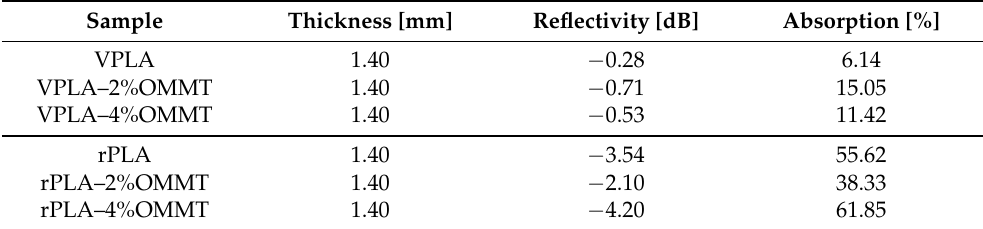
Table 2. Summary of reflectivity and absorption performances for simulated virgin and recycled PLA–OMMT nanocomposites, averaged over the 26.5–40 GHz frequency range for film having a thickness fixed at 1.4